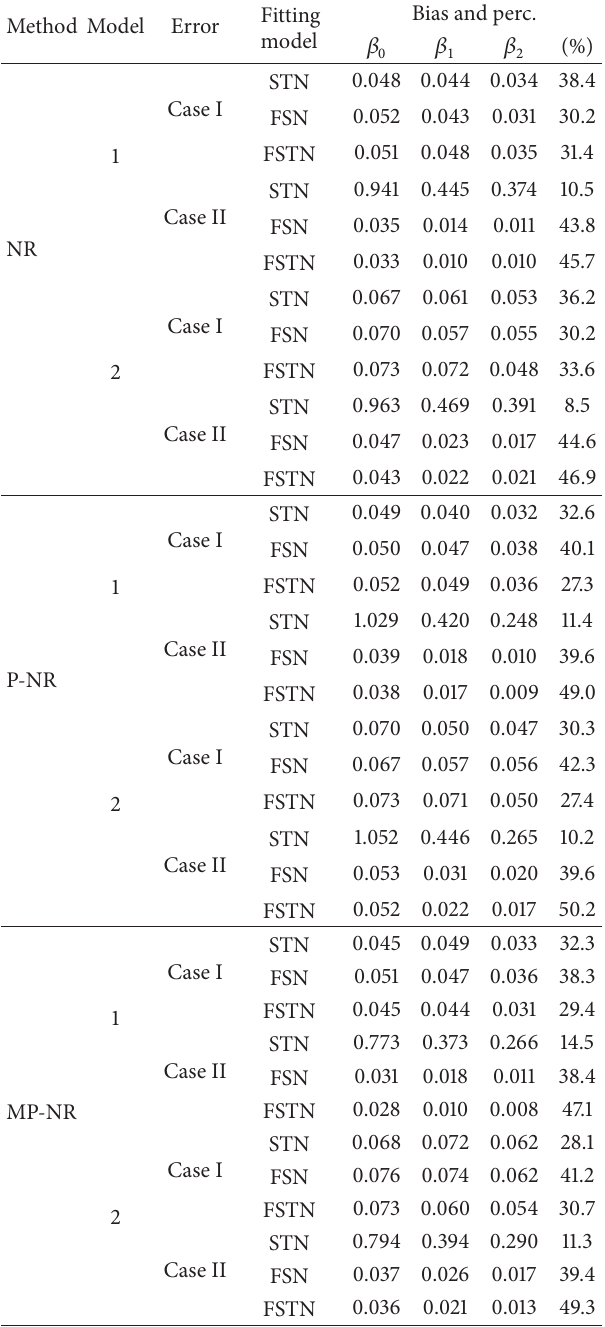
Table 1: Results of the simulation study. Method